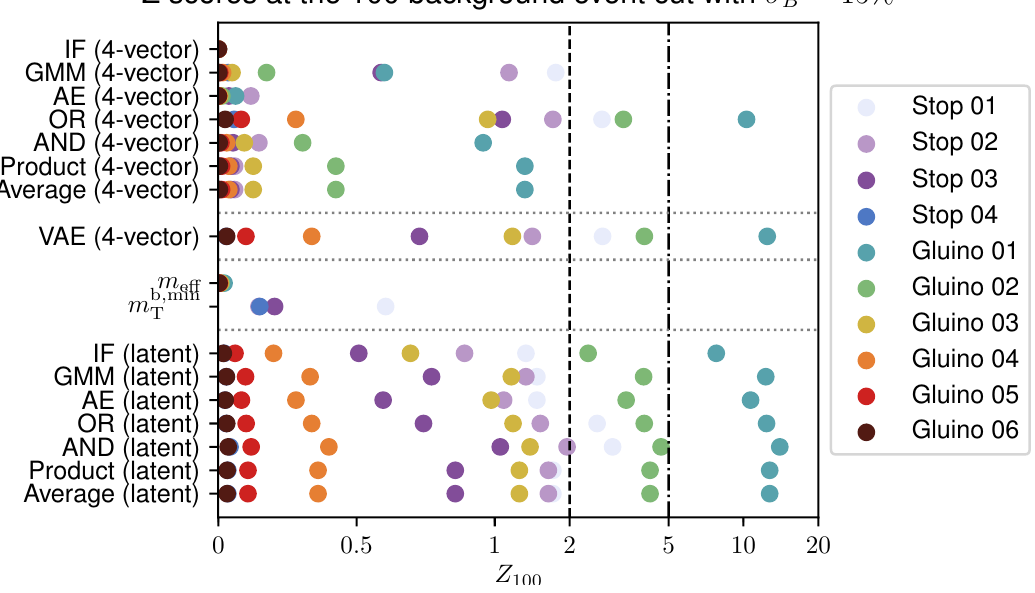
Figure 12 . Z scores yielded from various algorithms applied to 4-vector components and latent space representations with a 15% relative systematic uncertainty applied. See table 1 for the signal definitions, and table 3 for the definitions of the